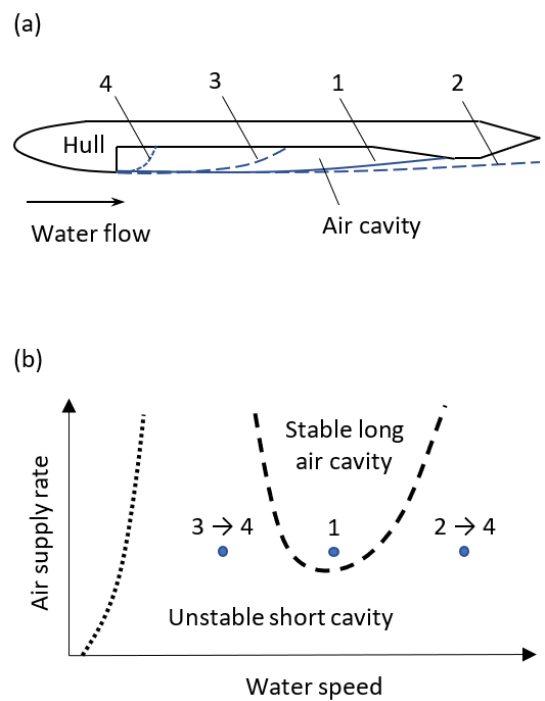
Figure 1. ( a ) Schematic of the recessed hull form (not-to-scale; vertical dimensions are exaggerated). Solid blue line 1, boundary of stable cavity at optimal water speed; dashed line 2, nominal air cavity at higher speed (unstable at low air supply); dashed line 3, nominal air cavity at lower speed (unstable at low air supply); dotted line 4, collapsed short air cavity. ( b ) Stability boundaries for long air cavity in the recessed hull setup. Dashed line shows stability boundary in the speed range of interest. Dotted line shows expected stability boundary at very low speeds.